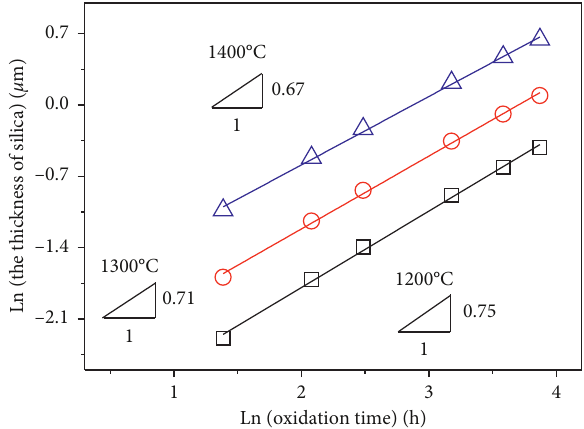
Figure 7: Oxidation kinetics of the SiC layer in air environment using a dual logarithm oxidation rate ( μ m 2 /h). It is noted that B/A and B are the rate coefficients for the interfacial reaction and the diffusion of oxidants, respectively. By fitting the relationship between the